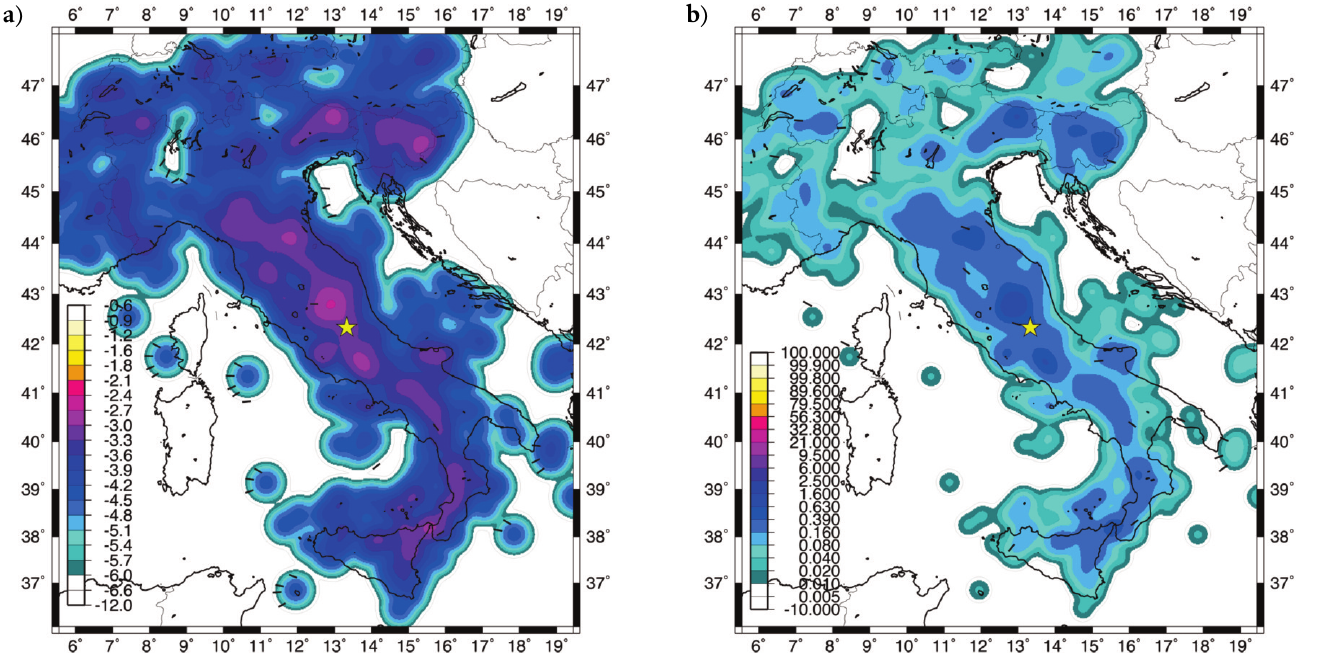
≥ 5.0 events per year in each cell) for the L ≥ 5.0 predicted in 10 km × 10 km cells around each rates of events per year for M 10 L